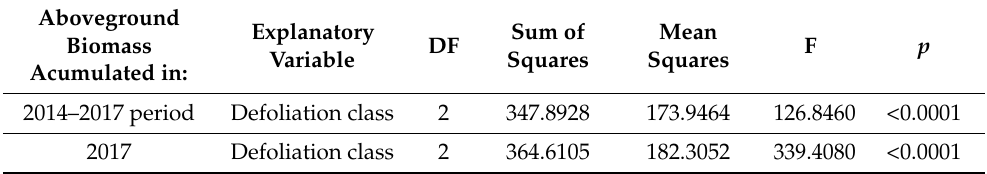
Table 3. Summary statistics for differences between total biomass accumulation and previous year biomass accumulation, depending on the defoliation class (ANOVA one way).